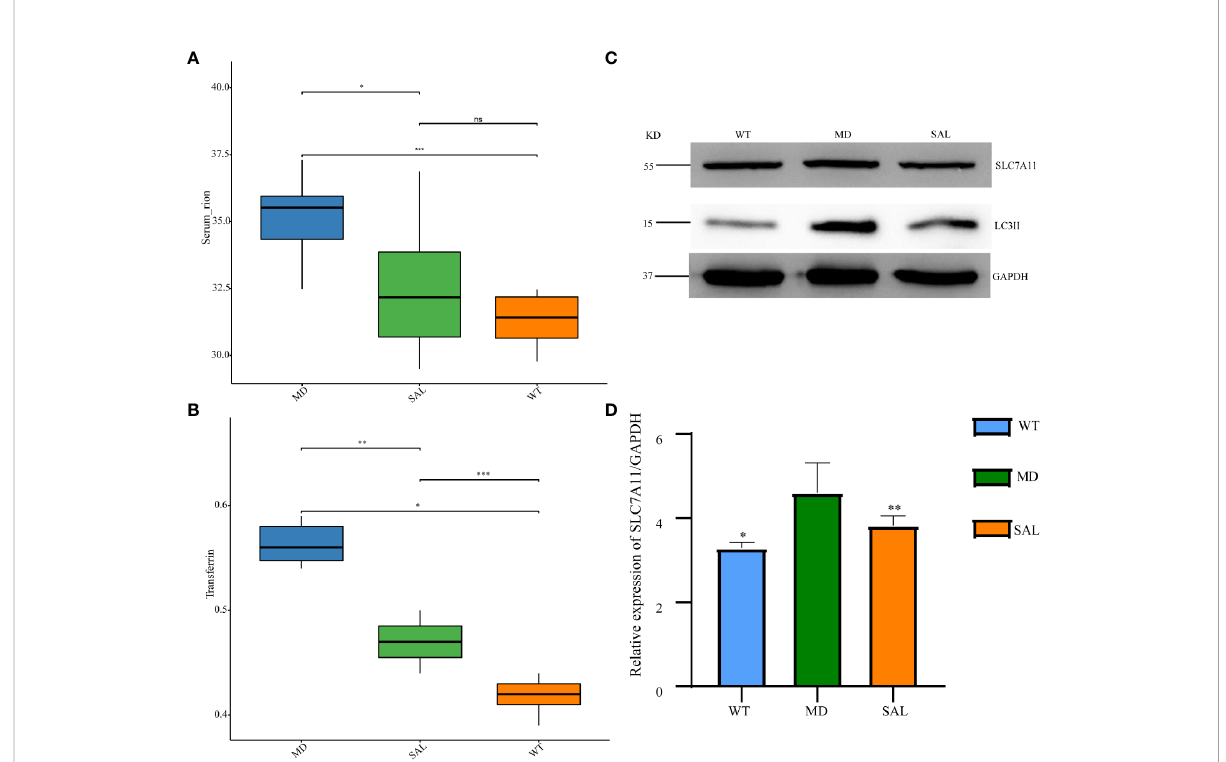
FIGURE 3 In fl uence of SAL on iron metabolism in diabetic mice. (A) , The serum iron levels of mice in the different groups; (B) , The transferrin levels of mice in the different groups; (C) Western blot analysis of the protein expression of SLC7A11, LC3II, and GAPDH in myocardial tissue; (D) Grey value analysis of the western blot results. (ns, no statistical signi fi cance; * p < 0.05 as MD group vs WT group; ** p < 0.05 as MD group vs SAL group). ***means that SAL group compared with WT group is difference signi fi